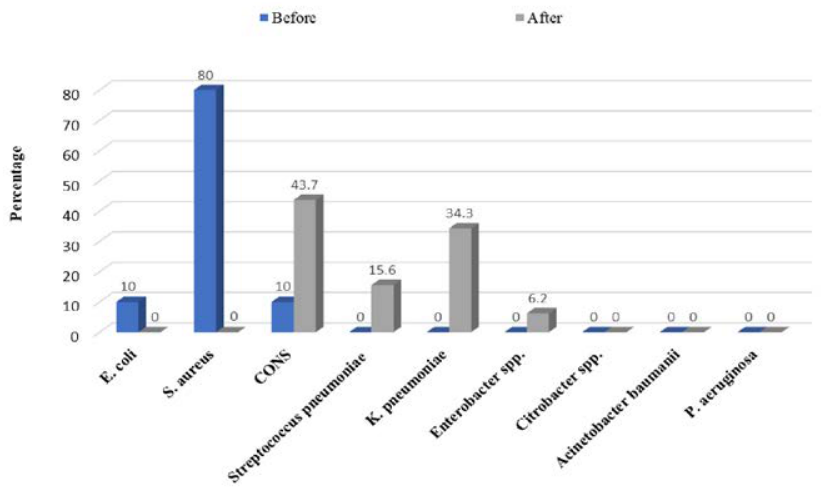
Fig. 2. Distribution of microorganisms isolated from environmental samples before and after the implementation of culture-based antibiotic policy and restricted infection control